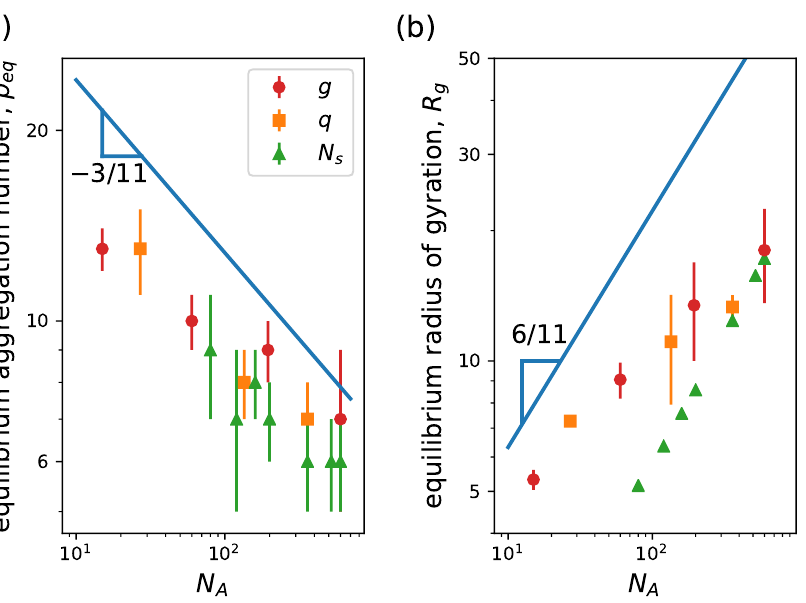
Figure 9. ( a ) Equilibrium aggregation number and ( b ) equilibrium radius of gyration versus degree of polymerization of the hydrophilic block N A . We consider linear–dendritic neutral block copolymer with N B = 15. Different type of dots correspond to simulation results with variations in N A by changing the indicated parameter, see Equation (5): red circle indicates variation of g = 0,1,2,3, with q = 3 and N s = 15; orange square for variation of q = 1,2,3 with g = 3 and N s = 9; and green triangle variation of N s = 2,3,4,5,6 with g = 3 and N s = 3. Lines correspond to scaling behavior predictions from mean-field SCF theory [47]. In ( b ), line corresponds to the scaling of the corona size ∝ N 6/11 . Other system parameters: w c = 2.5, (cid:101) attr = 1.0 and k B T = 1.0. A